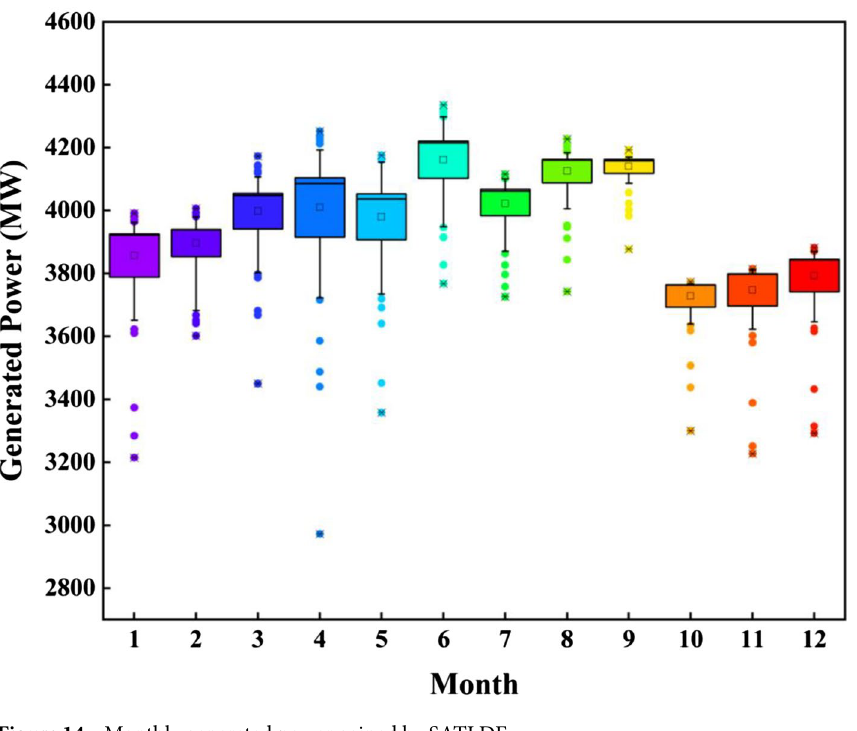
Figure 14. Monthly generated power gained by SATLDE.